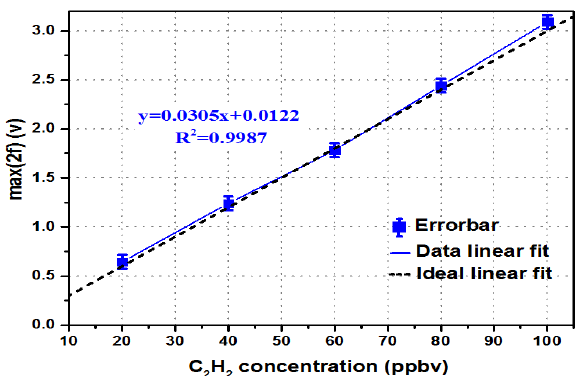
Figure 4. Relationship curves of max (2 f ) between the standard concentration and the measured concentration.